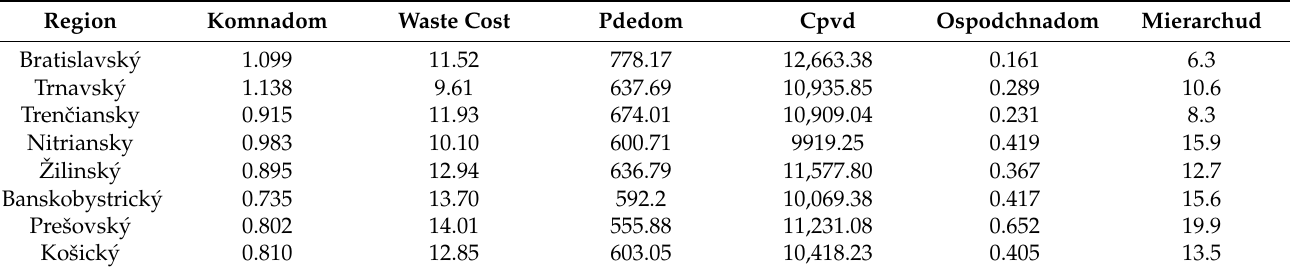
Table 7. Input data in 2012.